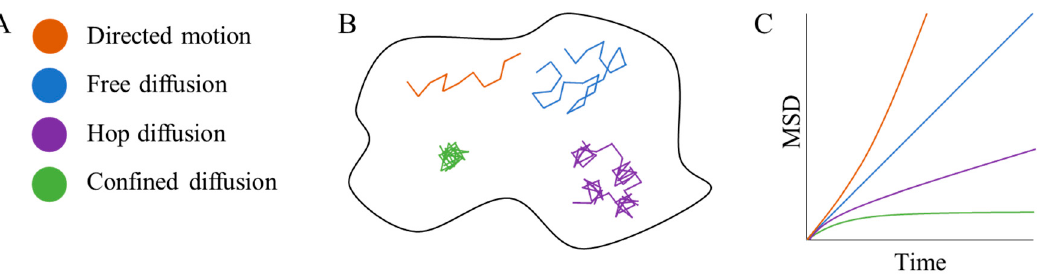
Figure 2. Overview of the most common transport behaviour detected via SPT analysis. The transport modes shown (directed motion, free diffusion, hop diffusion and confined diffusion) have been assigned a color in ( A ). ( B ) Color ‐ coded representative example trajectories for each transport behaviour. ( C ) Schematic of the mean square displacement (MSD) versus time plots calculated from the trajectories for the transport categories described in ( A , B ).